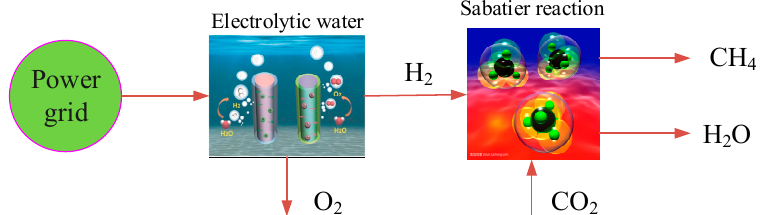
Figure 1. Production process of power to gas.